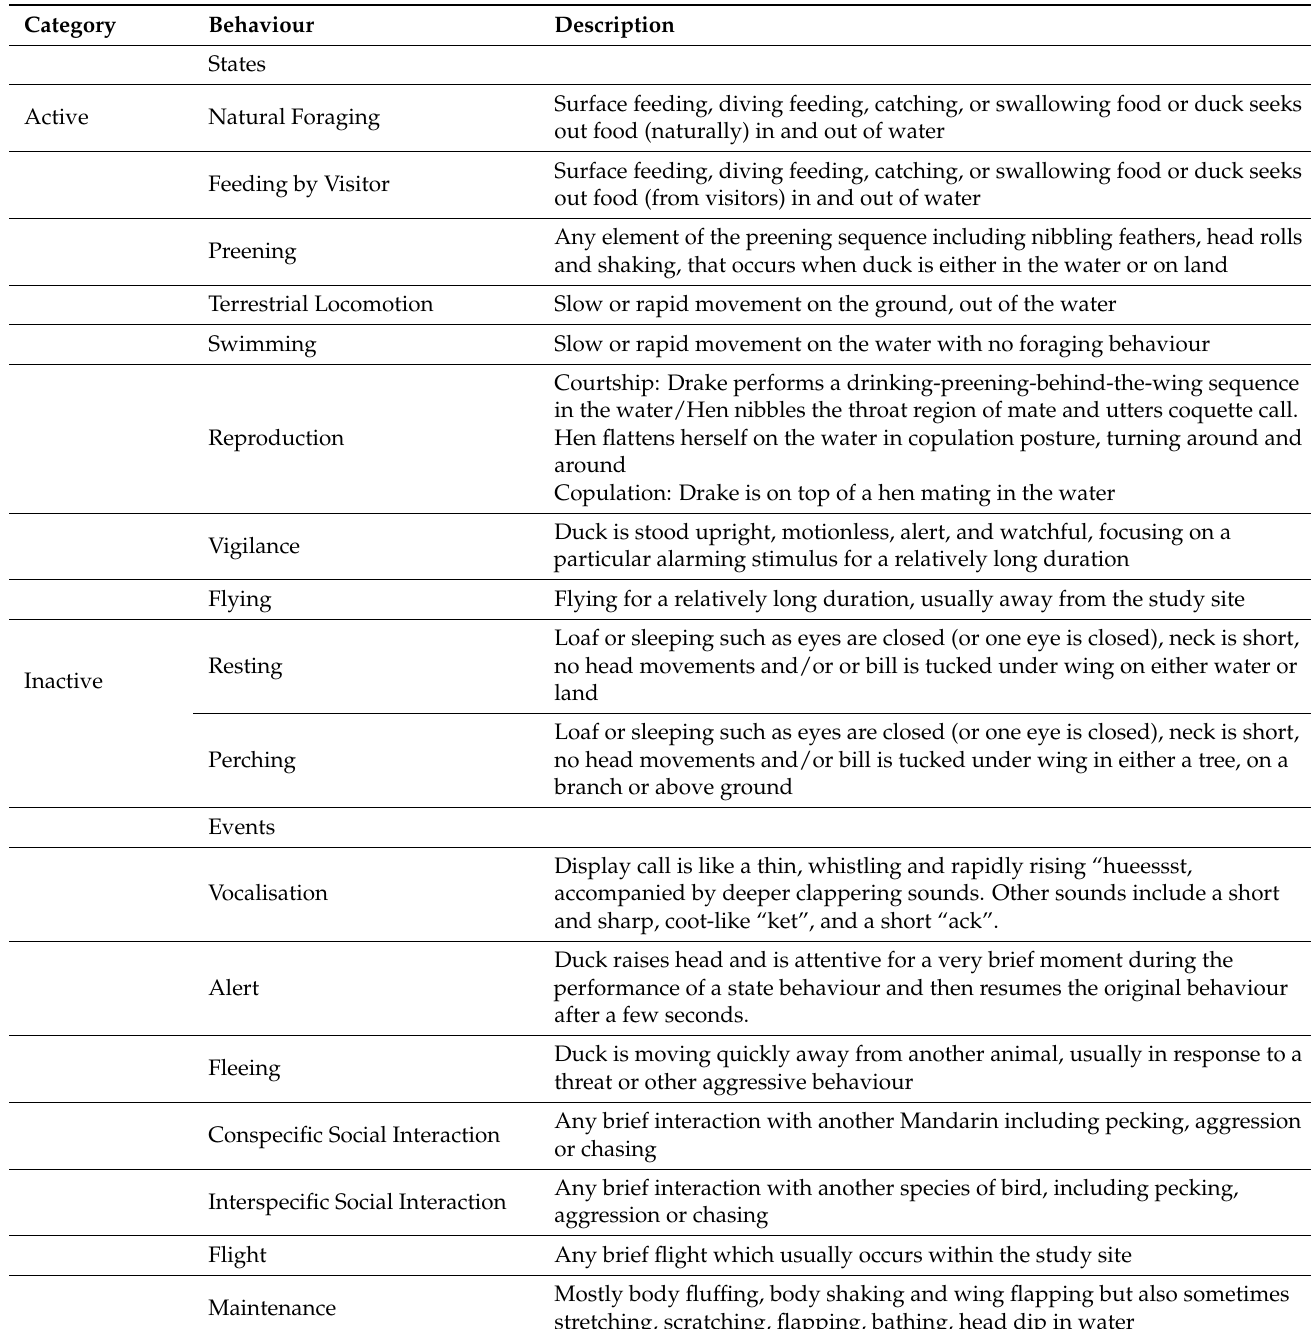
Table 1. Definitions of various state and event behaviours of Mandarins. Behaviour patterns of short duration (<5 s long) were classified as “Events” and those of a long duration (>5 s long) as “States”. Behaviours were also grouped into active and inactive states whereby Active is characterised by the presence of motion. When a bird went out of sight this was also